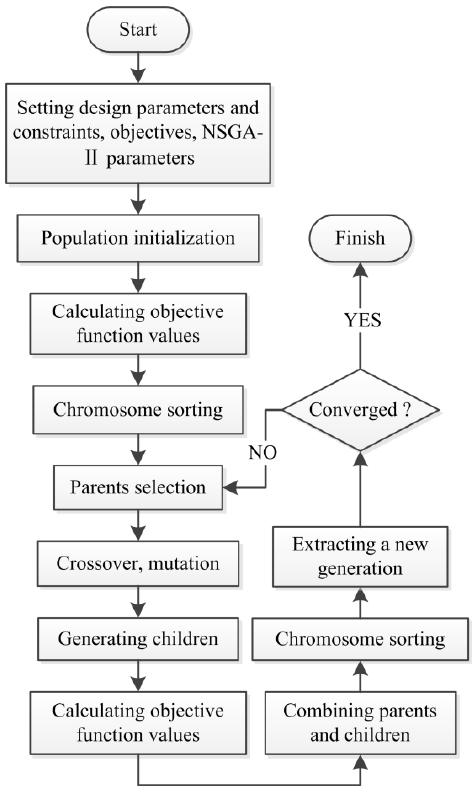
Figure 3. Flowchart of the optimization method.